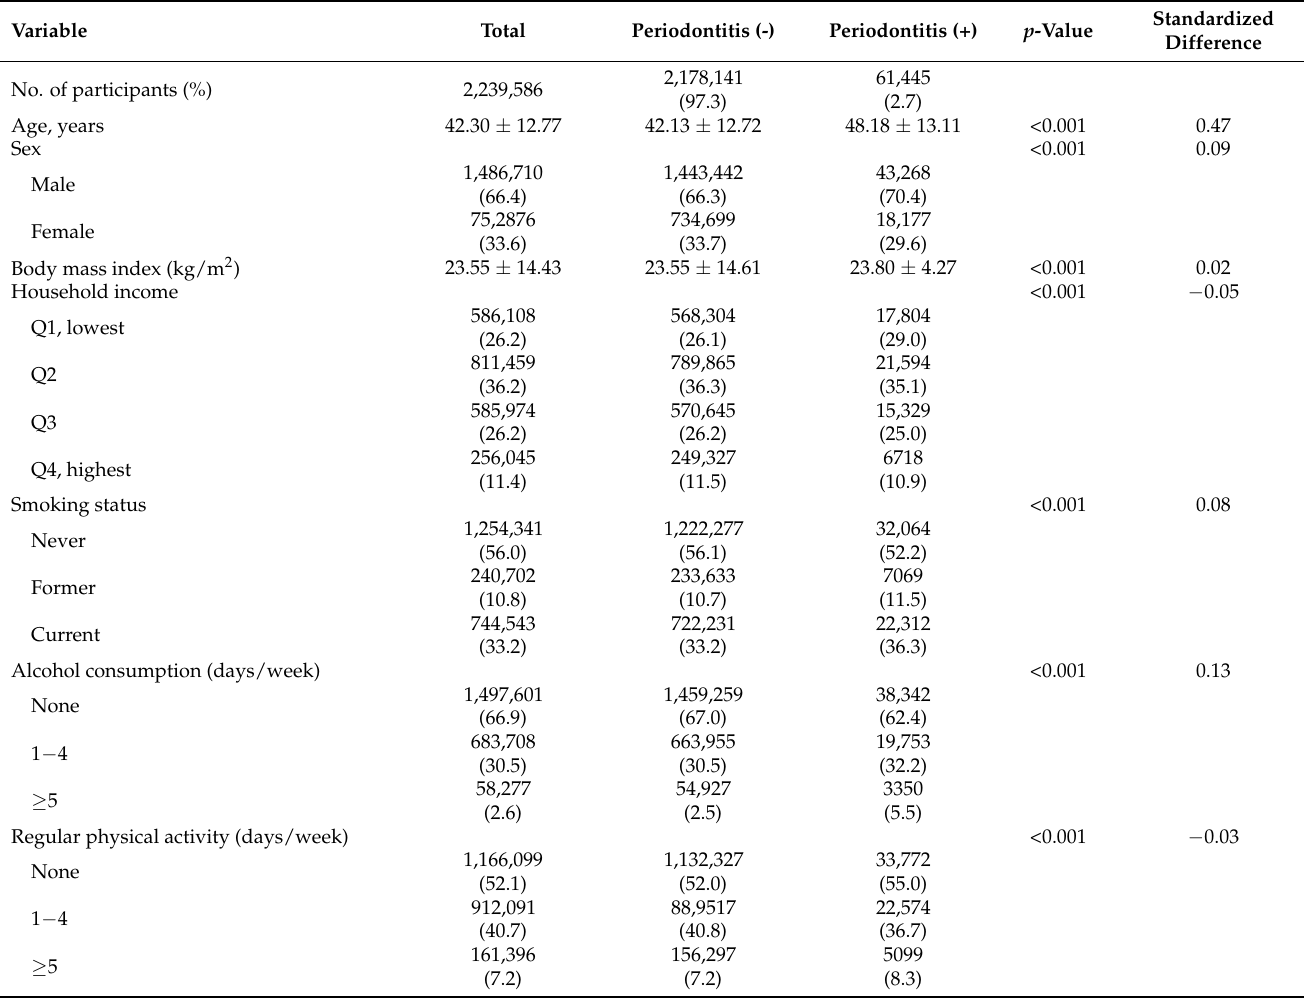
Table 1. Baseline characteristics of participants according to